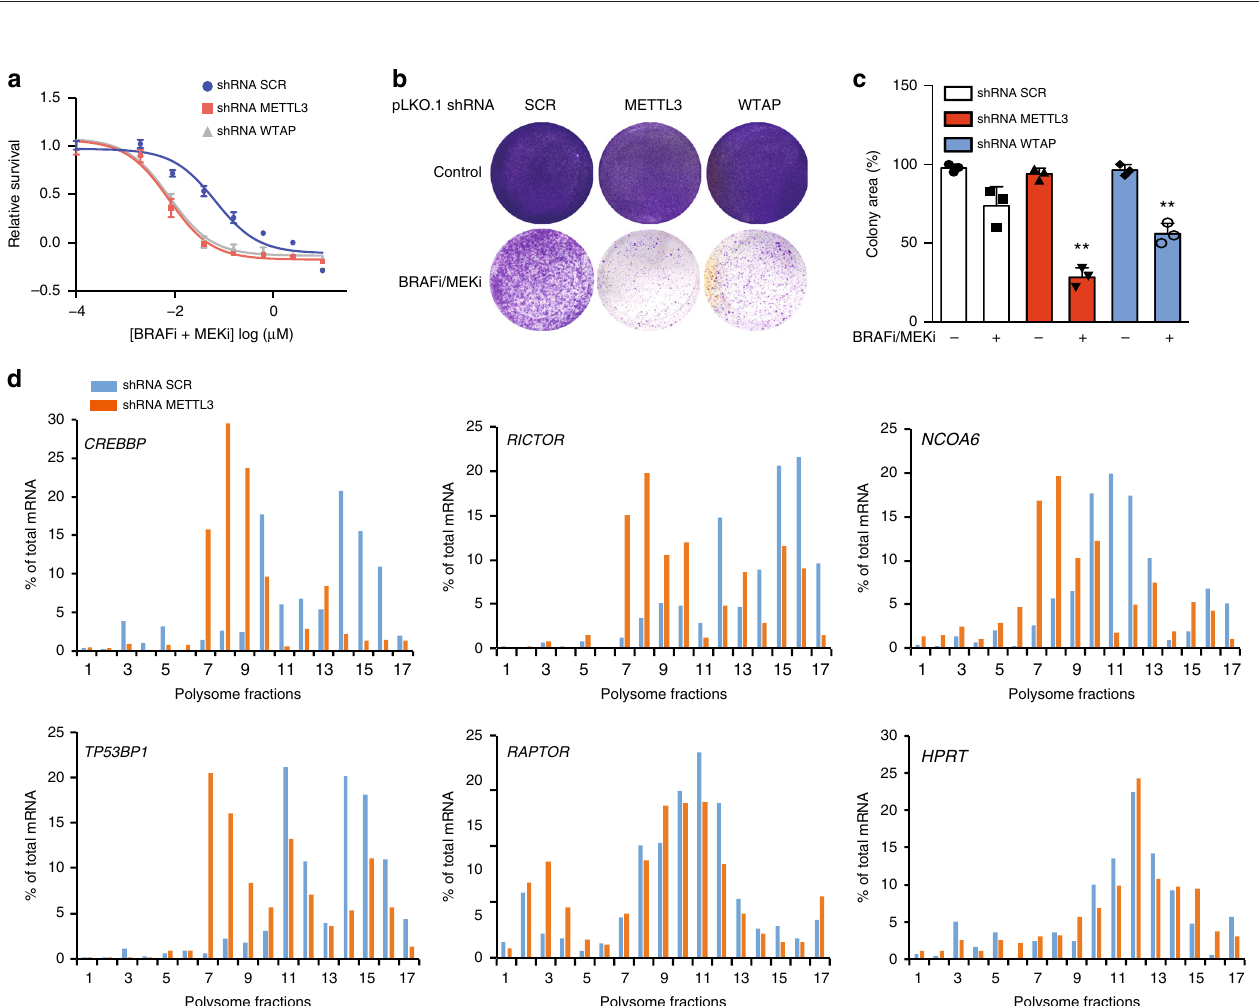
Fig. 5 m 6 A methyltransferase knockdown inhibits the translation remodelling and the survival of melanoma persister cells. a Short-term WST-1 cell viability analysis of the A375 melanoma cells expressing the indicated shRNAs upon the treatment of BRAFi/MEKi for 48 h. b , c m 6 A methylatransferase shRNA knockdown abrogates BRAFi/MEKi dependent persister cell-derived colony formation. An image representation ( b ) and the quanti fi cation on the clonogenic assay of persister cells are presented ( c ) ( n = 3, ** p -value < 0.001, unpaired t -test). d RT-qPCR quanti fi cation of mRNAs in fractions obtained by sucrose-gradient ultracentrifugation of lysates from persister cells in the presence or absence of shRNA METTL3. The raw data of a , c and d are available in Source above-described RNA probe as compared with eIF4E and eIF4A3, whereas eIF4A2 was not detected (Supplementary Fig. 10b). We then investigated whether silvestrol could abrogate the polysomal m 6 A enrichment in persister cells. Although silvestrol did not